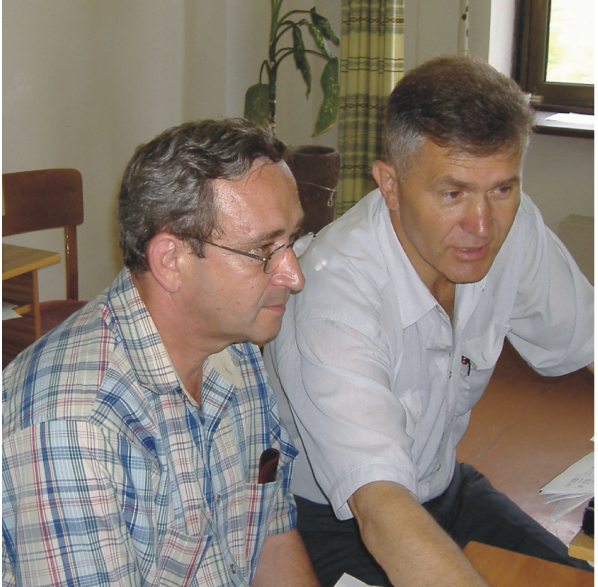
Figure 1. Oleg Zatsarinny (1953–2021) and Victor Gedeon (1955–2020) discuss their calculations at the Department of Theoretical Physics, Institute of Electron Physics NANU (2015). Photograph taken from private collection of Lyudmila